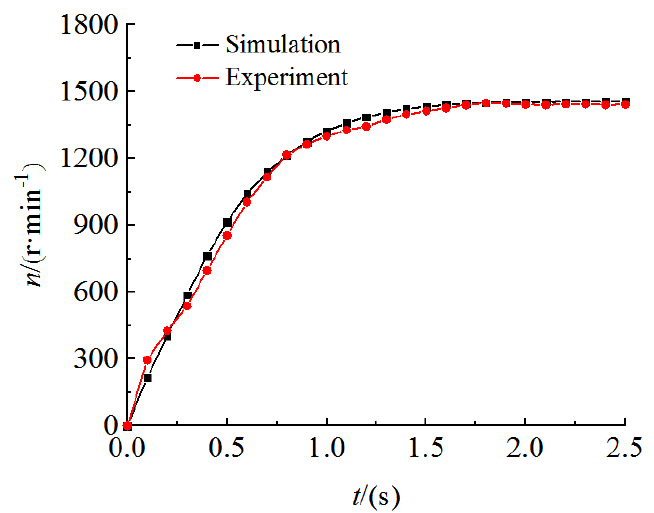
Figure 8. The comparison of rotating speed during calculation and experiment.